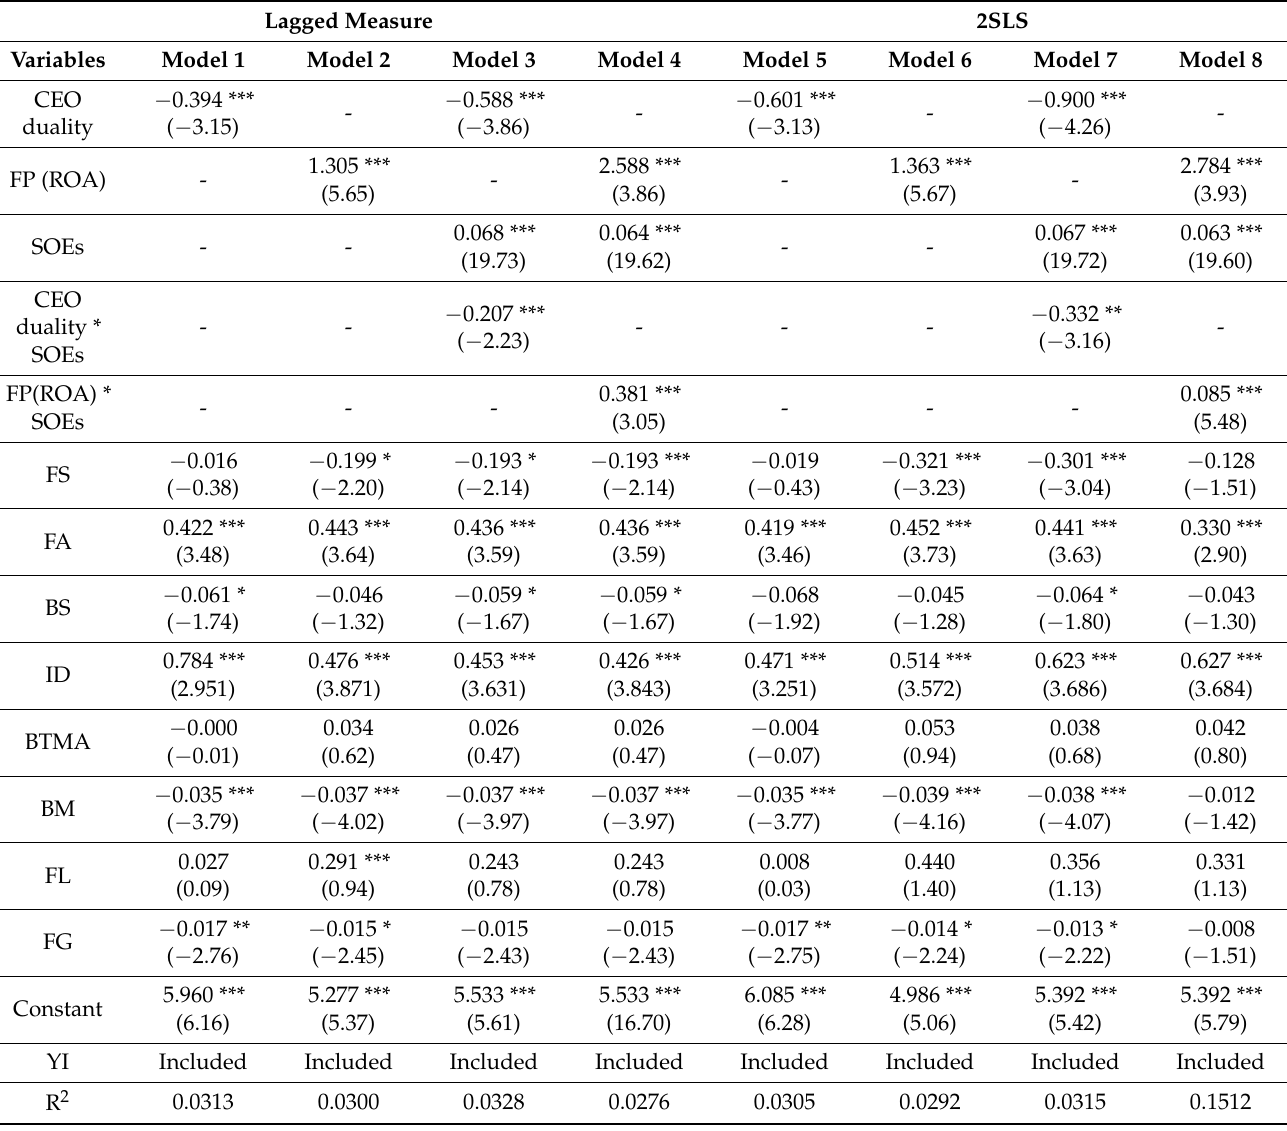
Table 6. Results of impact of CEO duality and financial performance (ROA) on CSR disclosure, and moderating role of SOEs (robustness two-stage least square